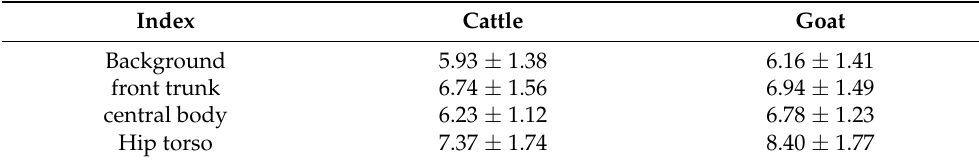
Table 4. Hausdorff distance of body segmentation between cattle and goat (mm).